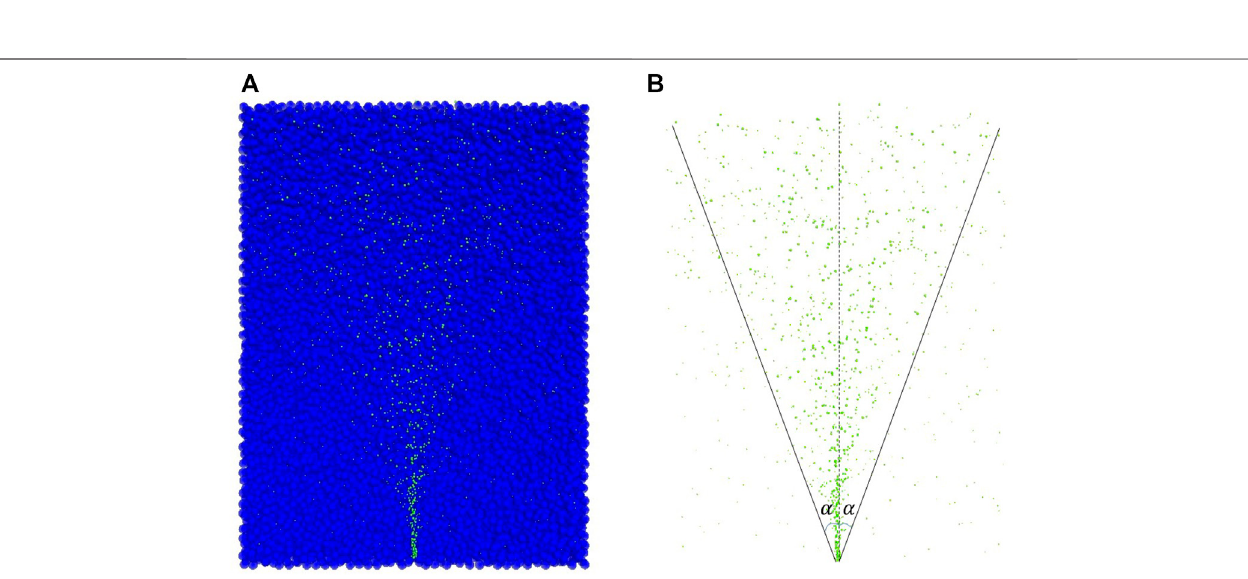
FIGURE 3 | DEM model of air sparging (A) Bubble motions in soil particles, (B) Aeration angle α .